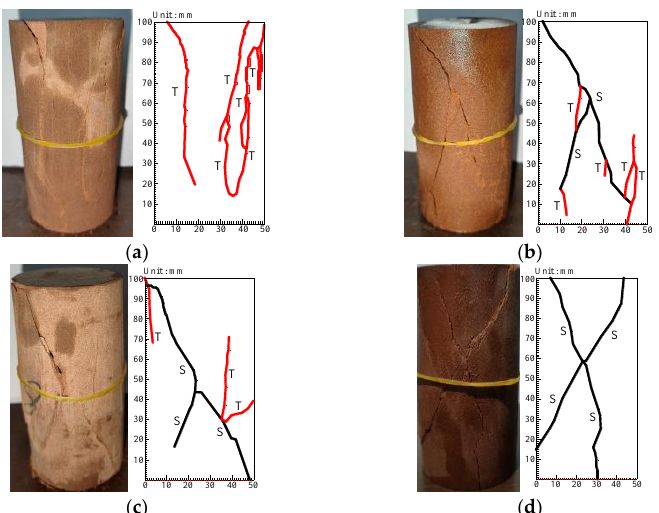
Figure 9. Morphological characteristics of sandstone pre-peak unloading rupture including unloading points: ( a ) 75%, ( b ) 80%, ( c ) 85%, ( d ) 90%.